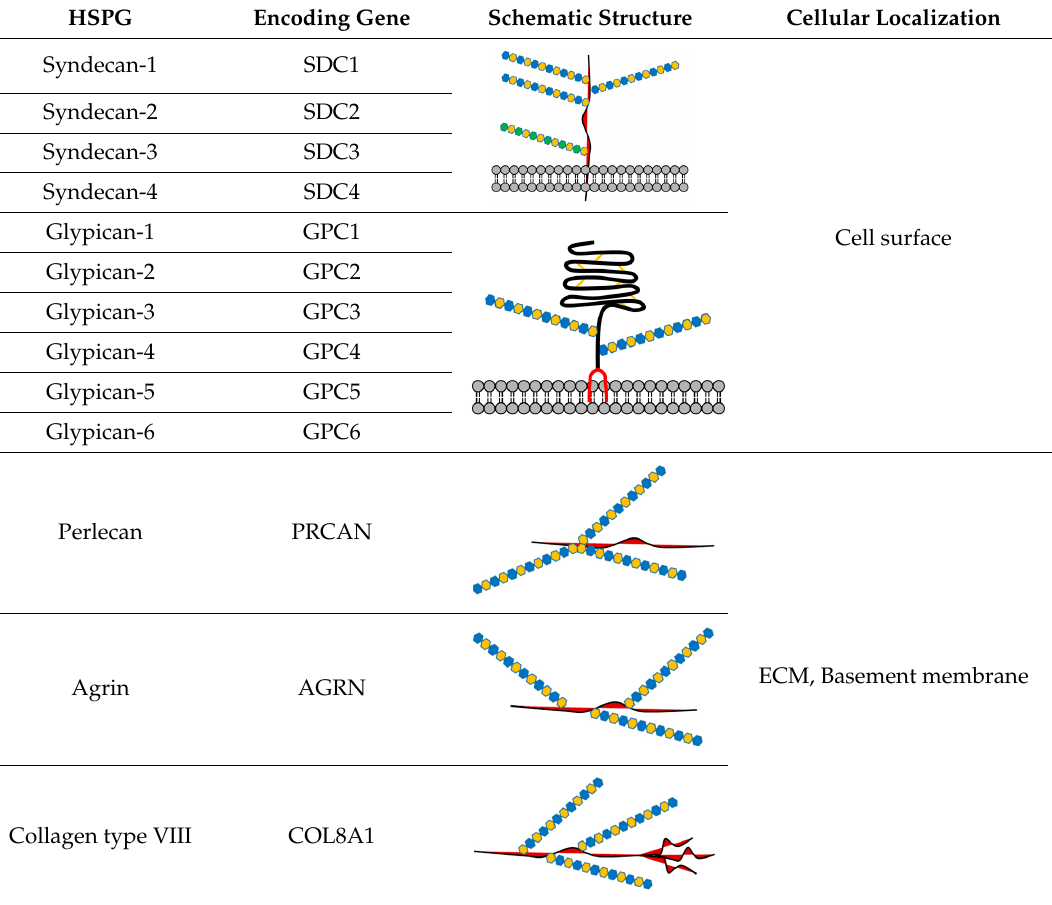
Table 1. Heparan sulfate proteoglycan ( HSPG) nomenclature, human genes, schematic structure, cellular localization.